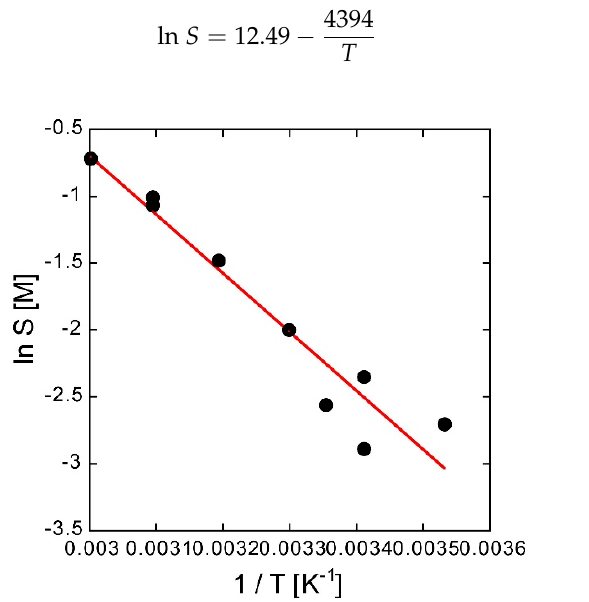
Figure 7. van't Hoff plot of solubility S of methylene blue in 1 mM MES buffer solution. Figure 7. Van’t Hoff plot of solubility S of methylene blue in 1 mM MES buffer solution.